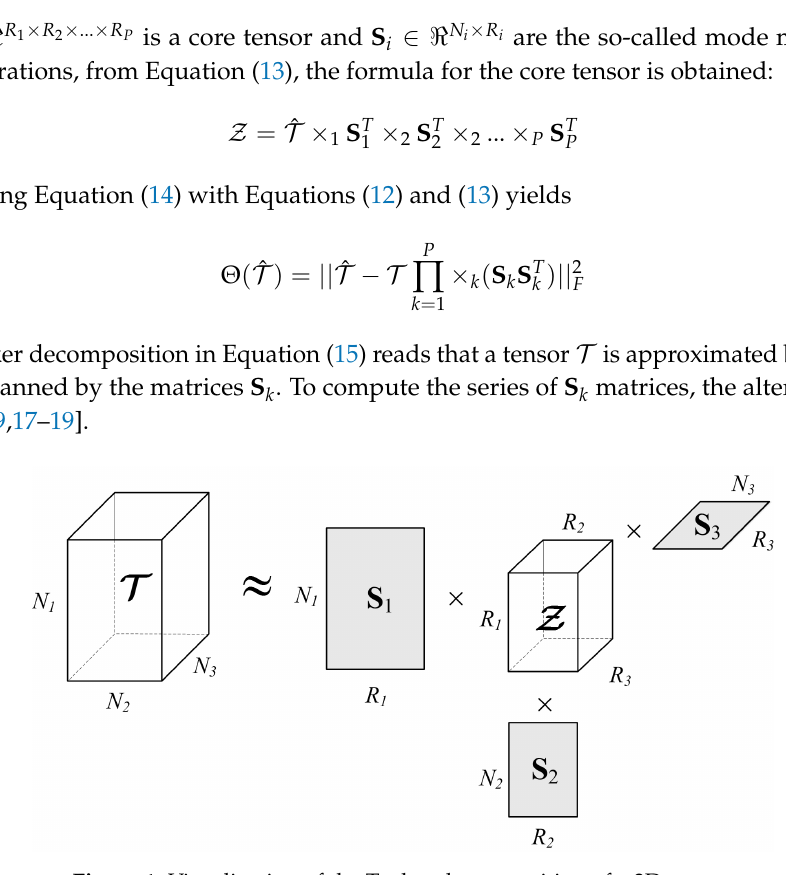
Figure 1. Visualization of the Tucker decomposition of a 3D